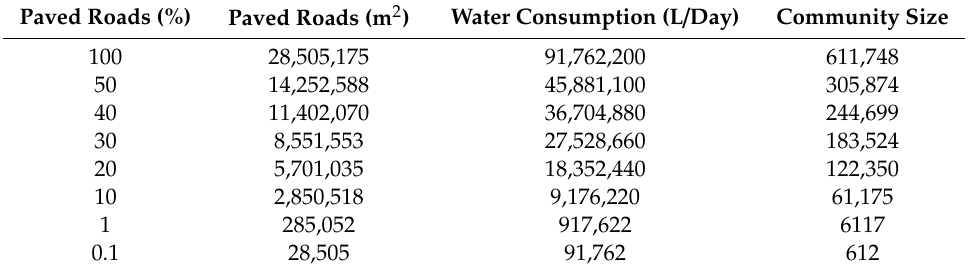
Table 2. Summary of paved roads area, community size, and water consumption. Paved Roads (%) Paved Roads (m 2 ) Water Consumption (L / Day) Community